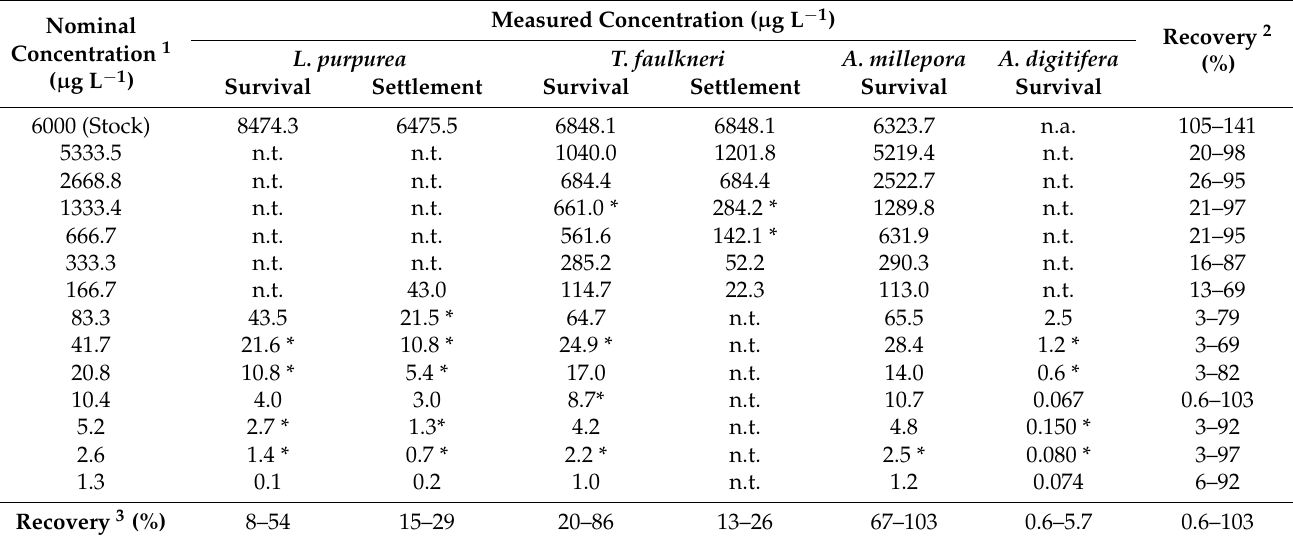
Table 1. Analytical results. Measured concentrations after 48 h presented for each species and experiment compared to nominal concentrations and